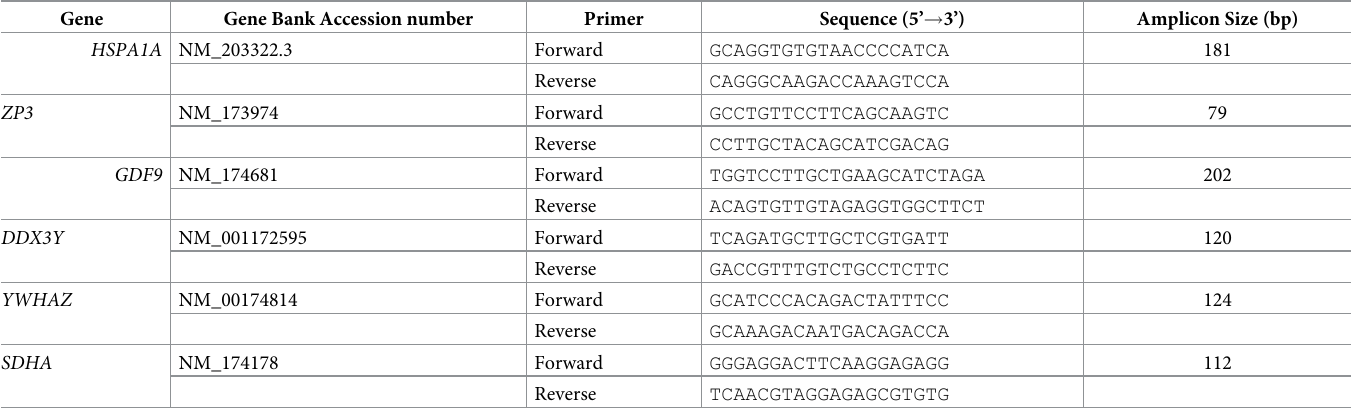
Table 1. Primers used for qPCR analysis.